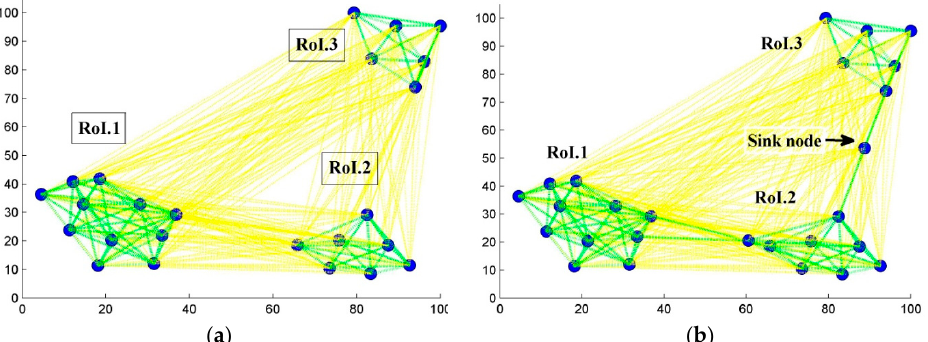
Figure 14. Illustration of WSN connection graph: ( a ) Before solving connectivity; ( b ) after solving connectivity.